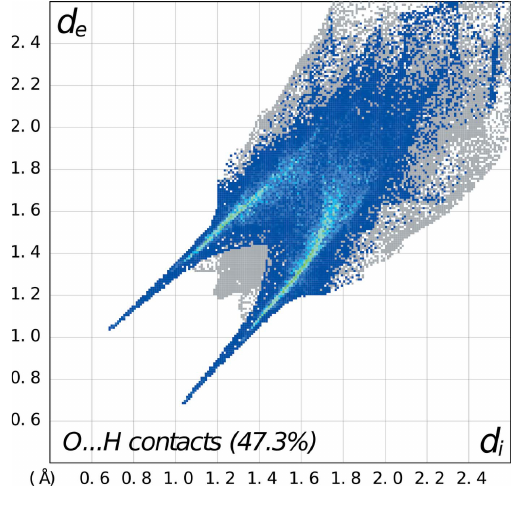
Figure 10 Fingerprint plot for 3 delineated into O (cid:2)(cid:2)(cid:2) H/H (cid:2)(cid:2)(cid:2) O contacts showing the prominent spikes as N—H (cid:2)(cid:2)(cid:2) O